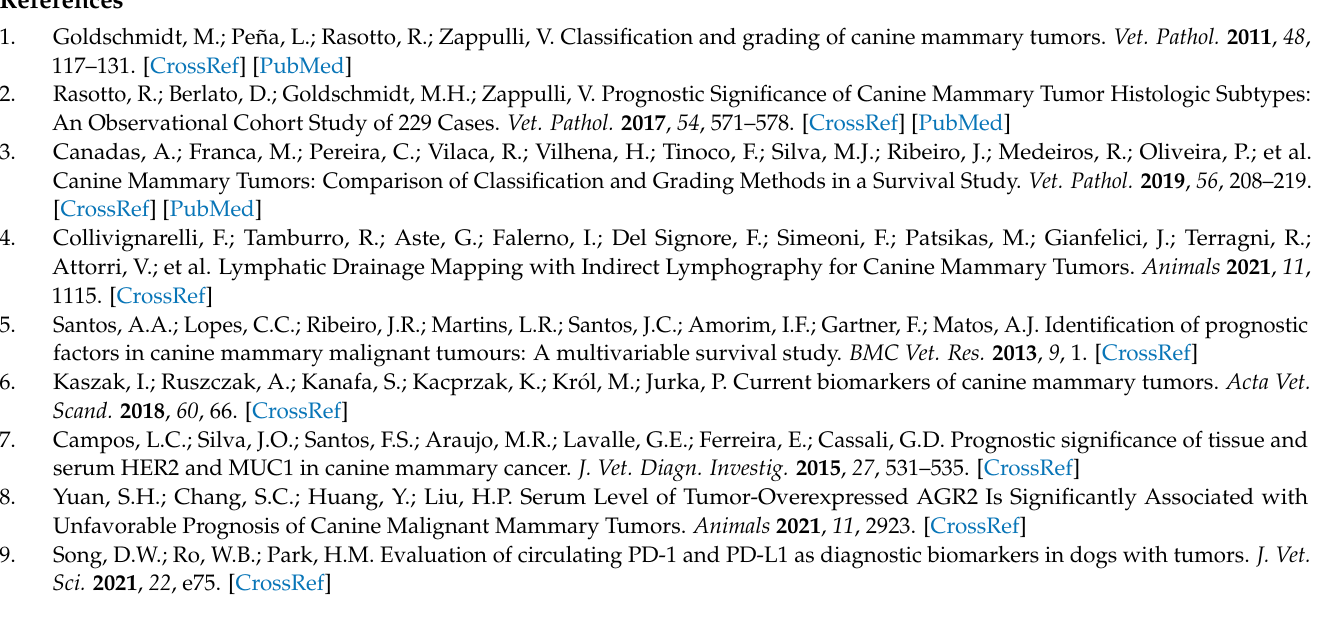
of 11 malignant CMT dogs enrolled for assessment of serum AAb levels before and after surgery; Figure S1: Detection of serum autoantibodies to TYMS, HAPLN1, or IGFBP5 by using immunoblot- ting; Figure S2: Original images of Figure